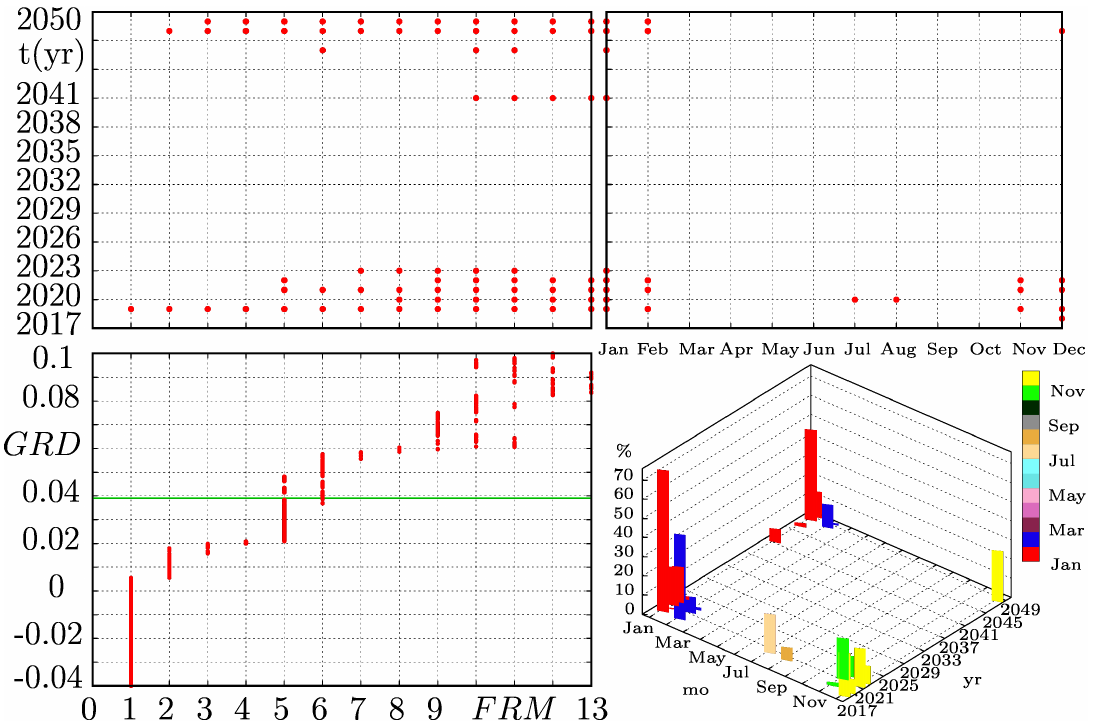
Figure 14. Diagram of the GRD scenarios once the ENSO phenomenon is incorporated in the model. FRM stands for frequency of rationing months. The Colombian case is marked by the green horizontal